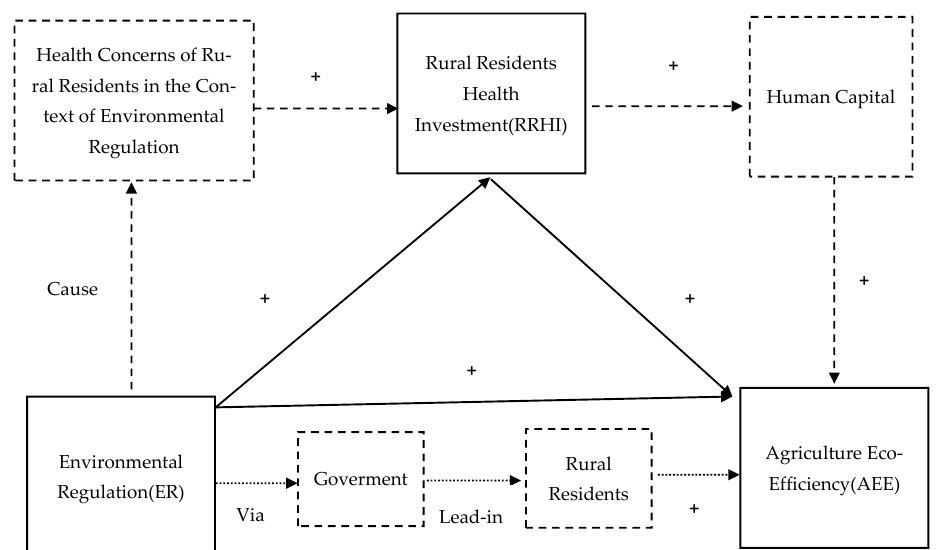
Figure 1. Mechanism analysis framework of ER , RRHI, and AEE .